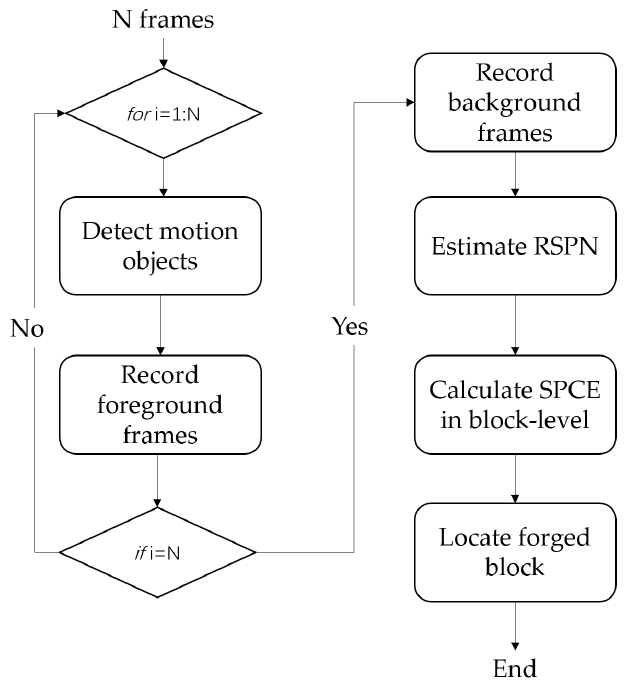
Figure 2. The flowchart of the proposed